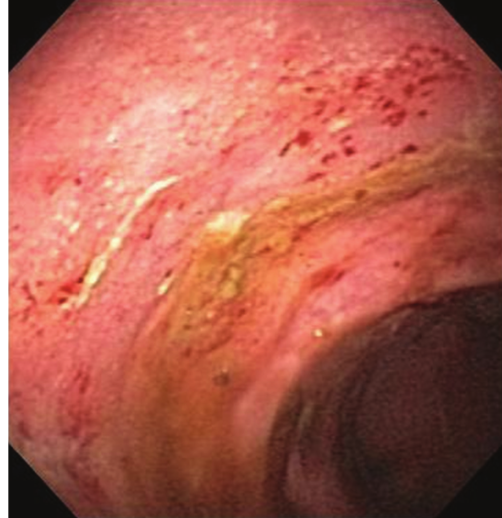
Figure 1: Picture of the patient’s colon taken during colonoscopy. The image reveals di ff use inflammation with submucosal hemor-